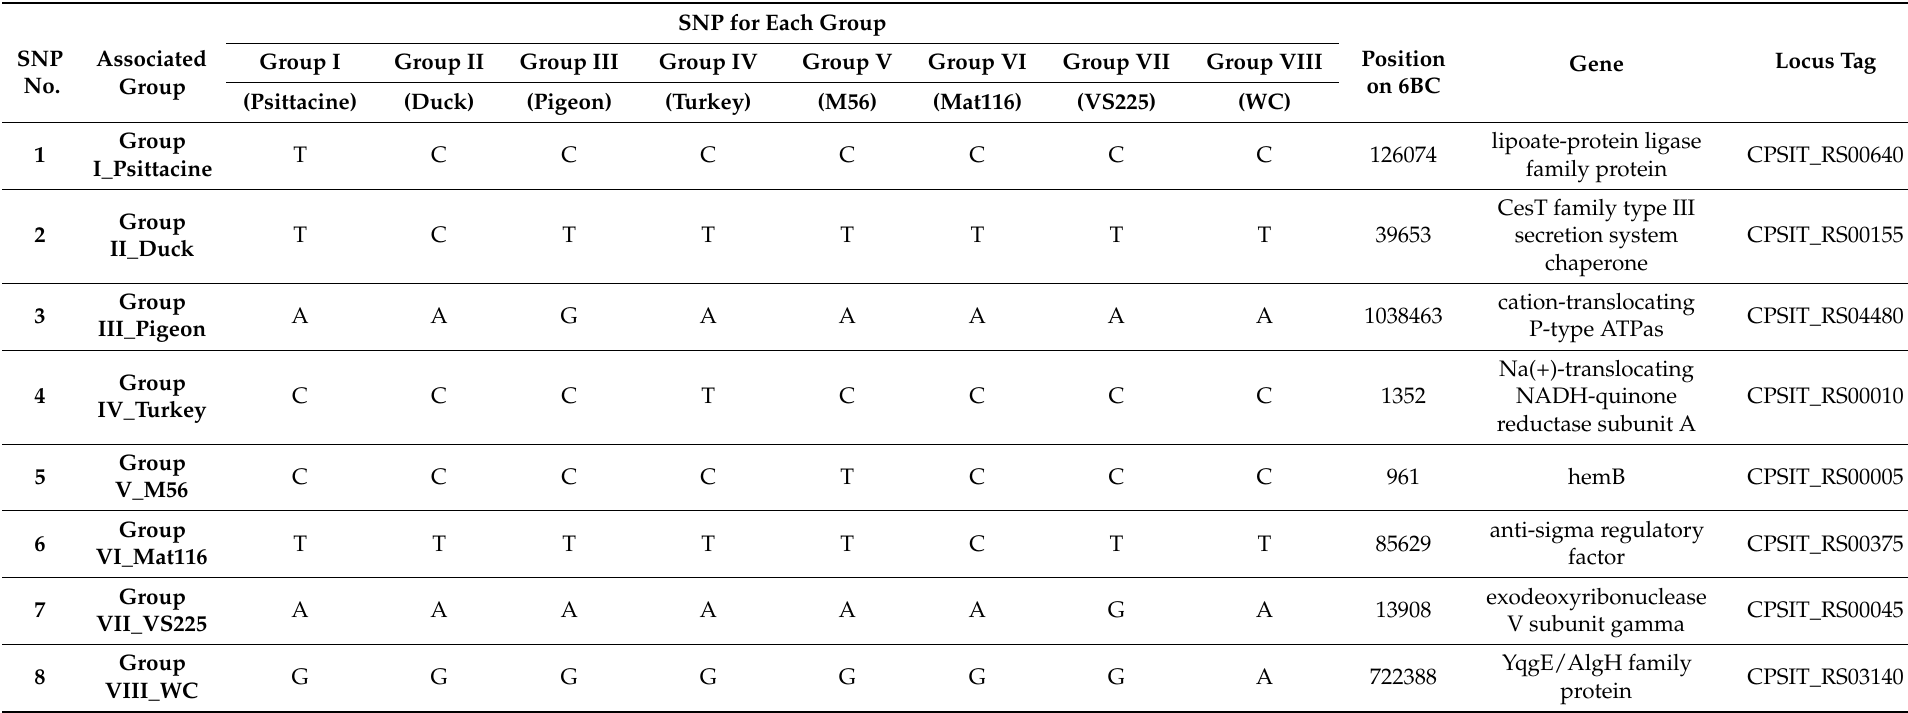
Table 2. List of selected single-nucleotide polymorphisms (SNPs) used for this study. SNPs specific to each group are in bold. SNP for Each